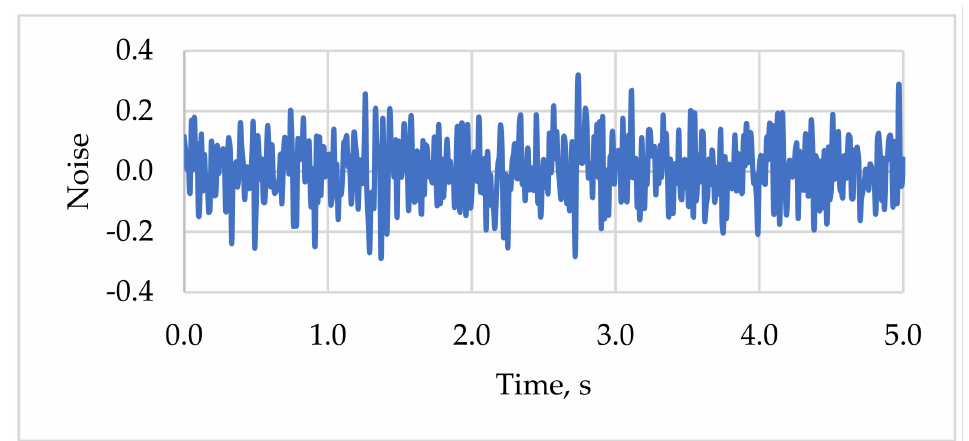
Figure 8. Sensor noise